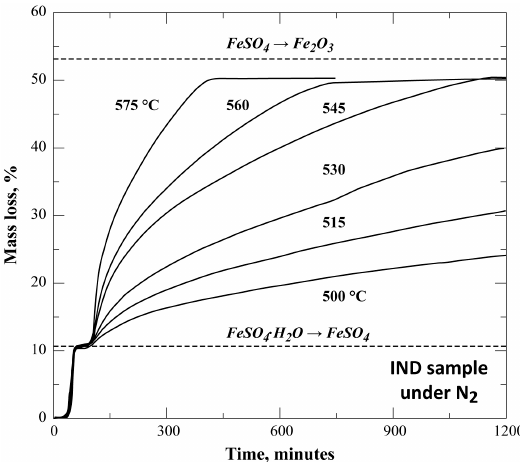
Figure 7. Evolution of the percent mass loss (% ML) as a function of time during the isothermal treatment of an industrial sample under nitrogen between 500 and 575 °C.